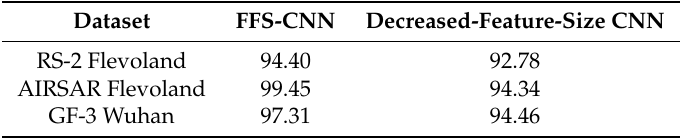
Table 6. The classification OAs of FFS-CNN and decreased-feature-size CNN (%).